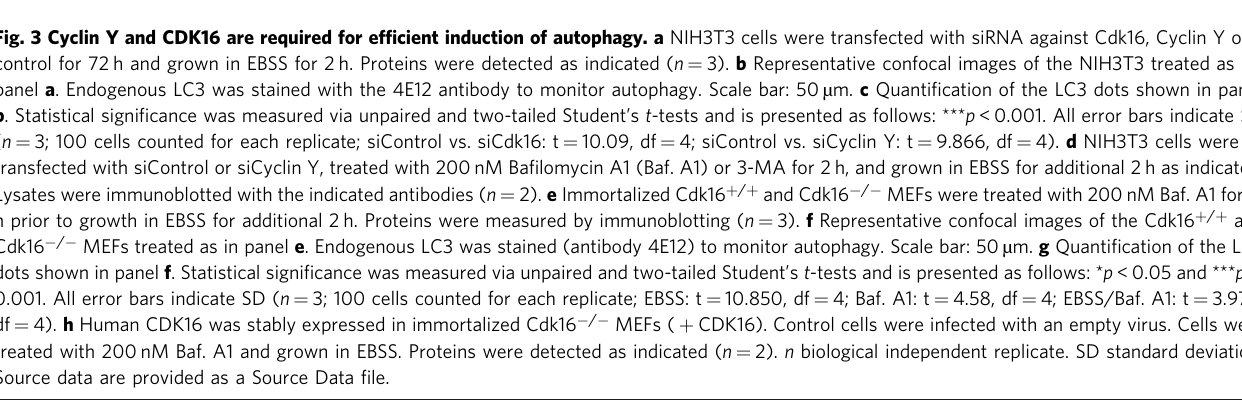
Fig. 3 Cyclin Y and CDK16 are required for ef fi cient induction of autophagy. a NIH3T3 cells were transfected with siRNA against Cdk16, Cyclin Y or a control for 72 h and grown in EBSS for 2 h. Proteins were detected as indicated ( n = 3). b Representative confocal images of the NIH3T3 treated as in panel a . Endogenous LC3 was stained with the 4E12 antibody to monitor autophagy. Scale bar: 50 µ m. c Quanti fi cation of the LC3 dots shown in panel b . Statistical signi fi cance was measured via unpaired and two-tailed Student ’ s t -tests and is presented as follows: *** p < 0.001. All error bars indicate SD ( n = 3; 100 cells counted for each replicate; siControl vs. siCdk16: t = 10.09, df = 4; siControl vs. siCyclin Y: t = 9.866, df = 4). d NIH3T3 cells were transfected with siControl or siCyclin Y, treated with 200 nM Ba fi lomycin A1 (Baf. A1) or 3-MA for 2 h, and grown in EBSS for additional 2 h as indicated. Lysates were immunoblotted with the indicated antibodies ( n = 2). e Immortalized Cdk16 + / + and Cdk16 − / − MEFs were treated with 200 nM Baf. A1 for 4 h prior to growth in EBSS for additional 2 h. Proteins were measured by immunoblotting ( n = 3). f Representative confocal images of the Cdk16 + / + and Cdk16 − / − MEFs treated as in panel e . Endogenous LC3 was stained (antibody 4E12) to monitor autophagy. Scale bar: 50 µ m. g Quanti fi cation of the LC3 dots shown in panel f . Statistical signi fi cance was measured via unpaired and two-tailed Student ’ s t -tests and is presented as follows: * p < 0.05 and *** p < 0.001. All error bars indicate SD ( n = 3; 100 cells counted for each replicate; EBSS: t = 10.850, df = 4; Baf. A1: t = 4.58, df = 4; EBSS/Baf. A1: t = 3.978, df = 4). h Human CDK16 was stably expressed in immortalized Cdk16 − / − MEFs ( + CDK16). Control cells were infected with an empty virus. Cells were treated with 200 nM Baf. A1 and grown in EBSS. Proteins were detected as indicated ( n = 2). n biological independent replicate. SD standard